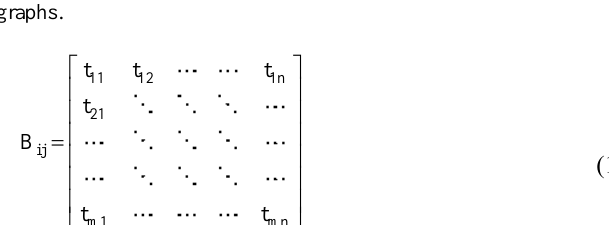
Fig. 2. Correspondence of